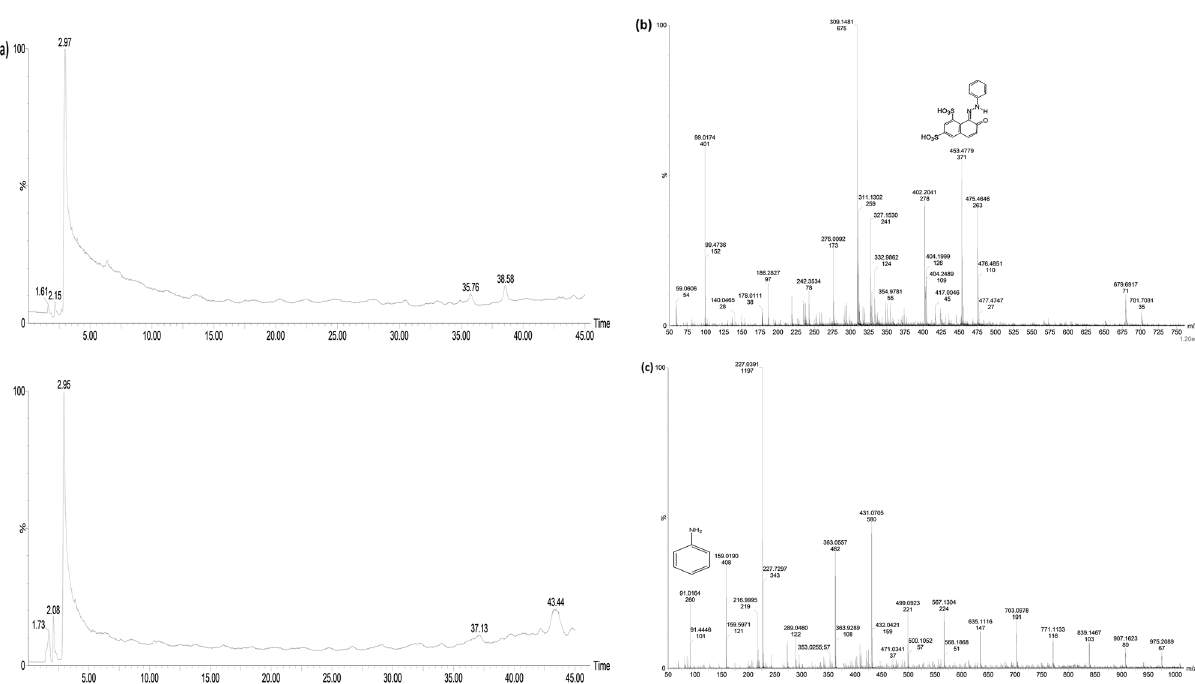
Figure 2. LCMS analysis of raw and treated textile